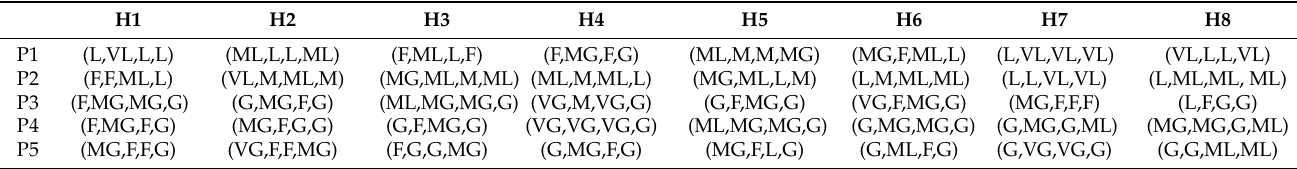
Table 5. LVs of WTE technology for MSW treatment method selection with respect to DEs.